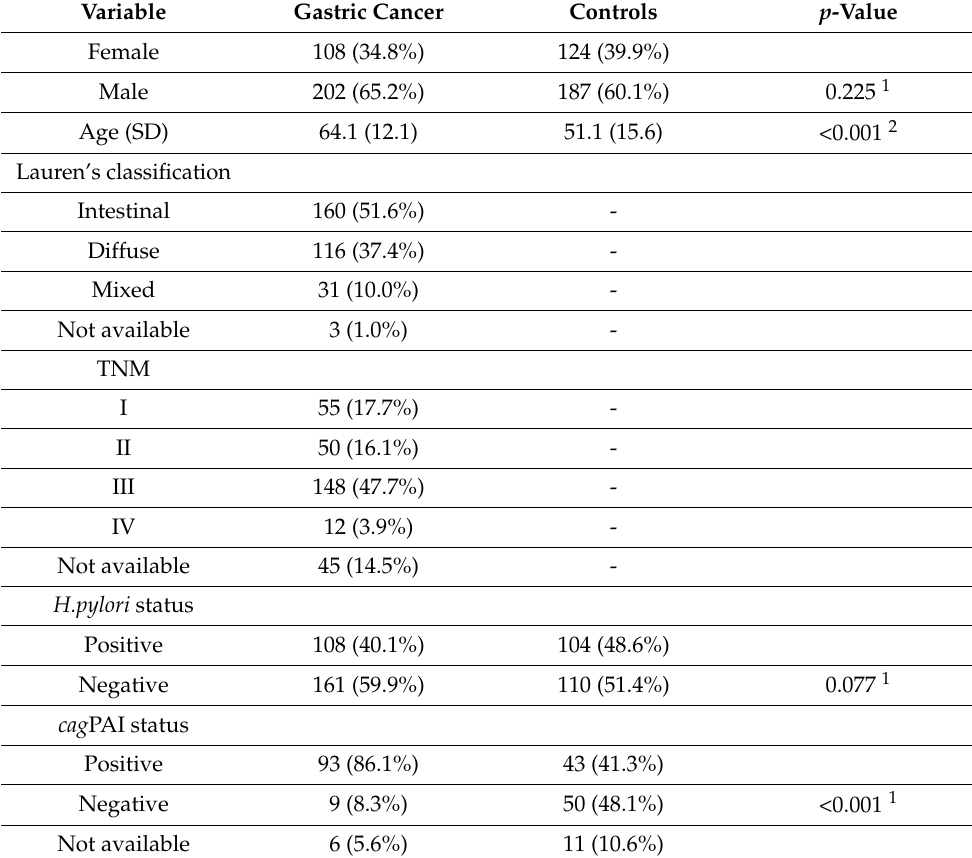
Table 1. Clinicopathological characteristics of gastric cancer cases and